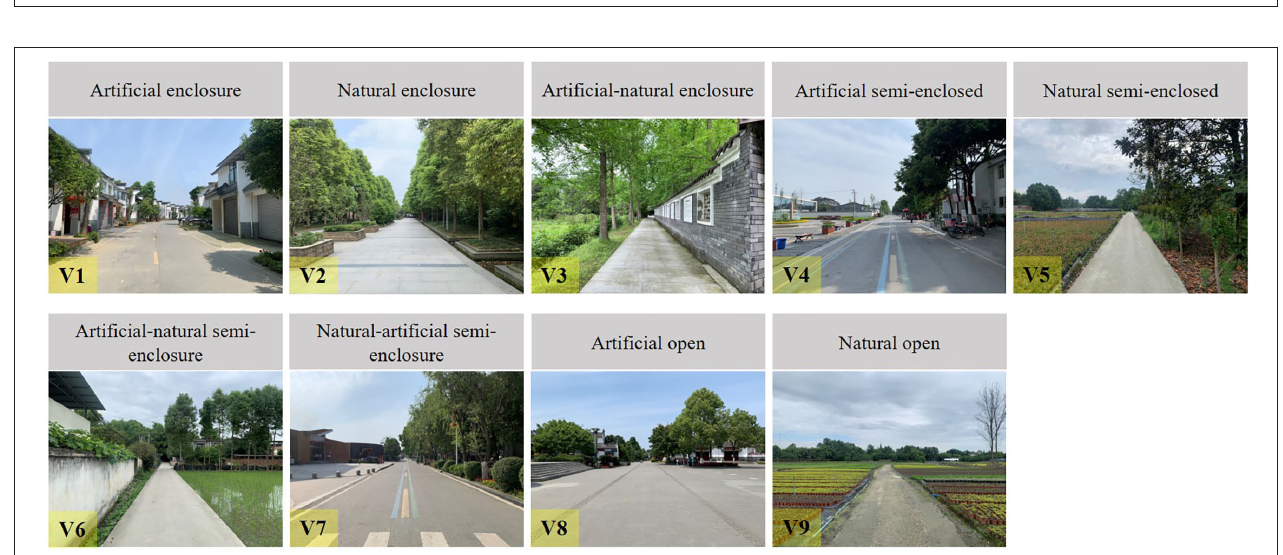
FIGURE 1 | Study area and the location of nine different types of streets.